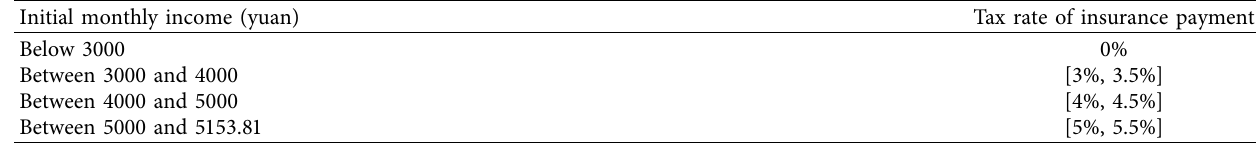
Table 4: Tax rate adjustment table for low-income groups to receive insurance